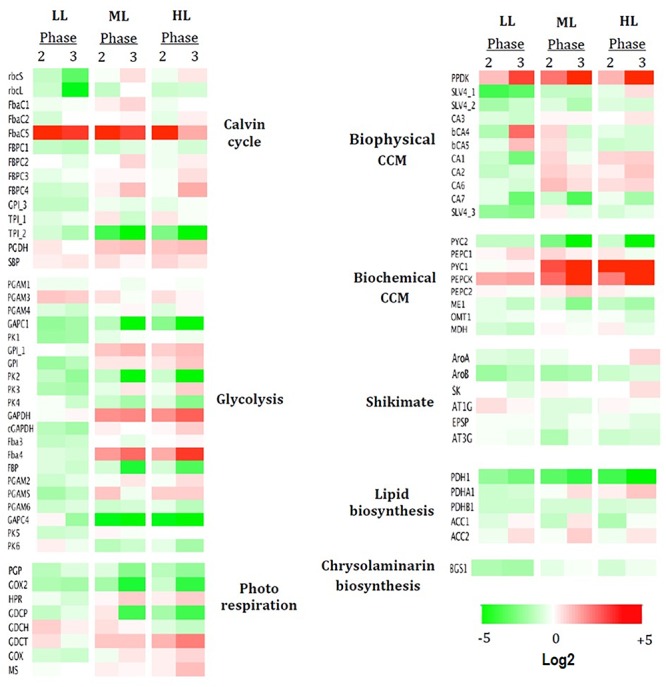
mRNA profiles of genes either up- or down-regulated during three growth phases under three light conditions. Are presented the log2 expression pattern of 74 genes related to carbon metabolic pathways, with the greatest differences in expression (red: high, green: low). Columns represent growth photon flux densities under the different growth phase, phase 1 being taken as reference. Heatmap performed using Netwalker 1.0. Dysregulated heatmap showing the expression pattern of 74 genes related to carbon metabolic pathways, with the greatest differences in expression (red: high, green: low). Columns represent three growth phases under low light (LL) and high light (HL). Heatmap performed using Netwalker 1.0.